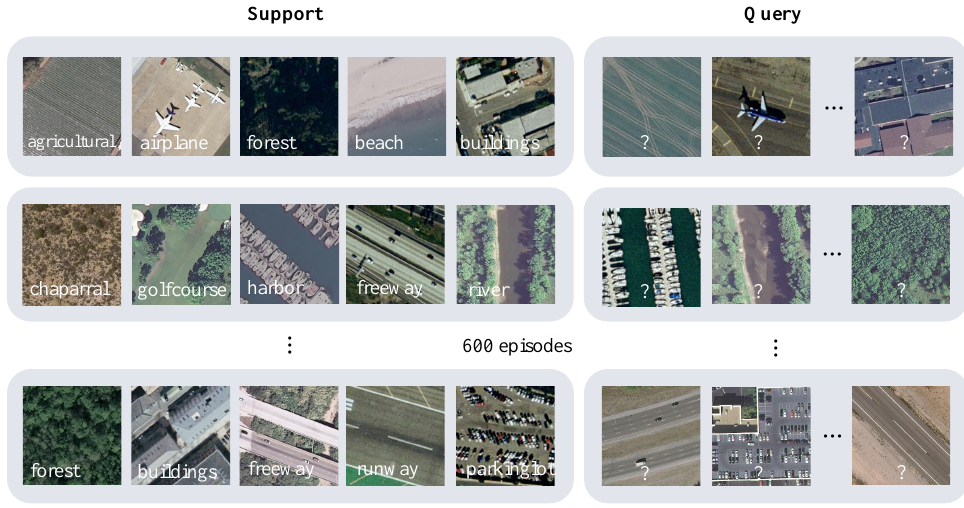
Figure 4. The example of a 5-way 1-shot